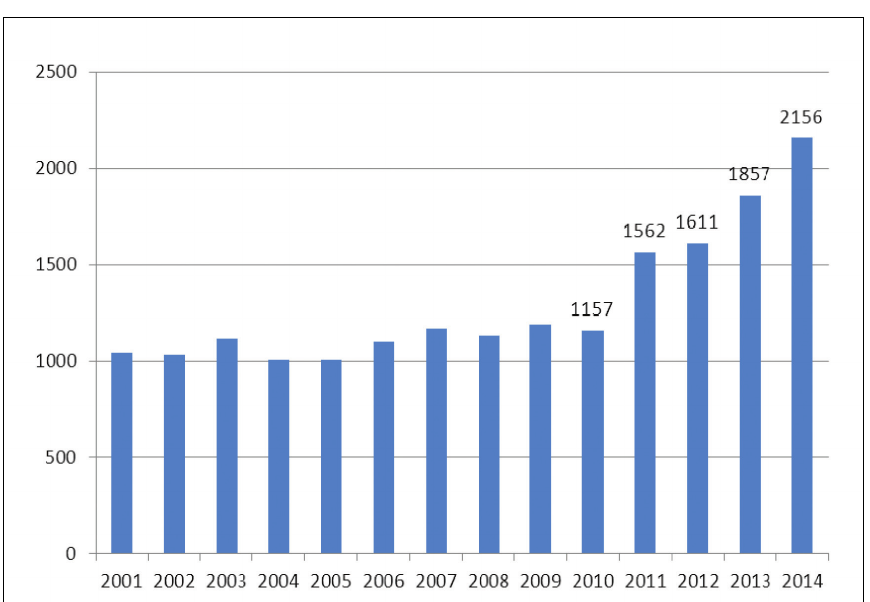
Note. The right column shows the interval between the first and the last start.